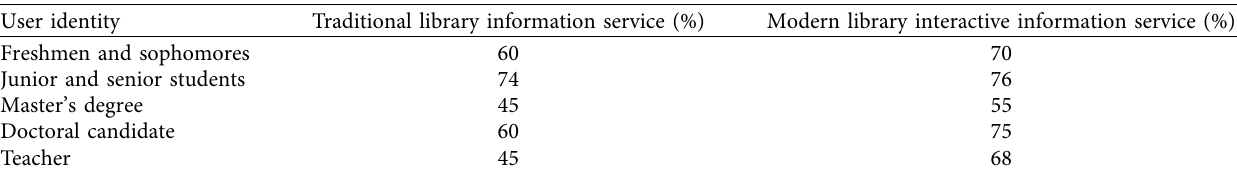
Table 3: Comparison of the user degree of traditional library information service and modern library interactive information service. User